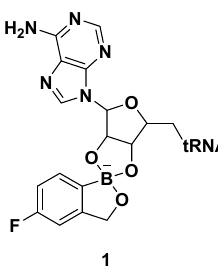
Figure 2. AN2690-tRNA Leu adduct via the oxaborole tRNA-trapping (OBORT) mechanism.